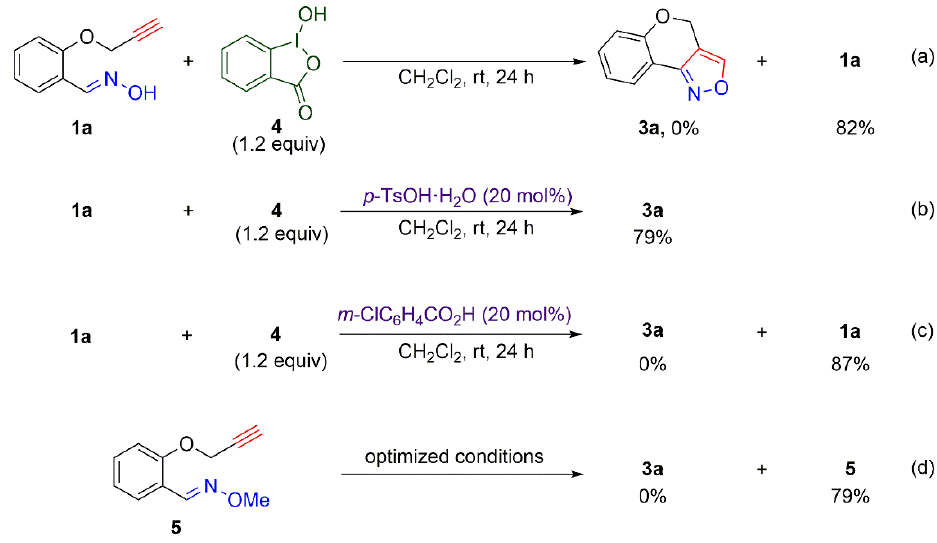
Figure 3. Control experiments.